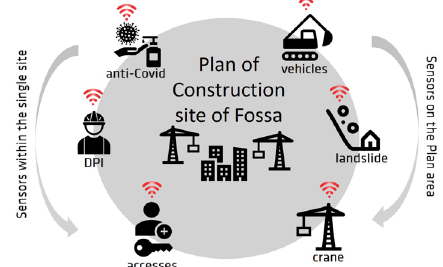
Figure 3. Monitoring via distributed sensor networks . The figure explains what wants to be monitored in the pit construction plan 1